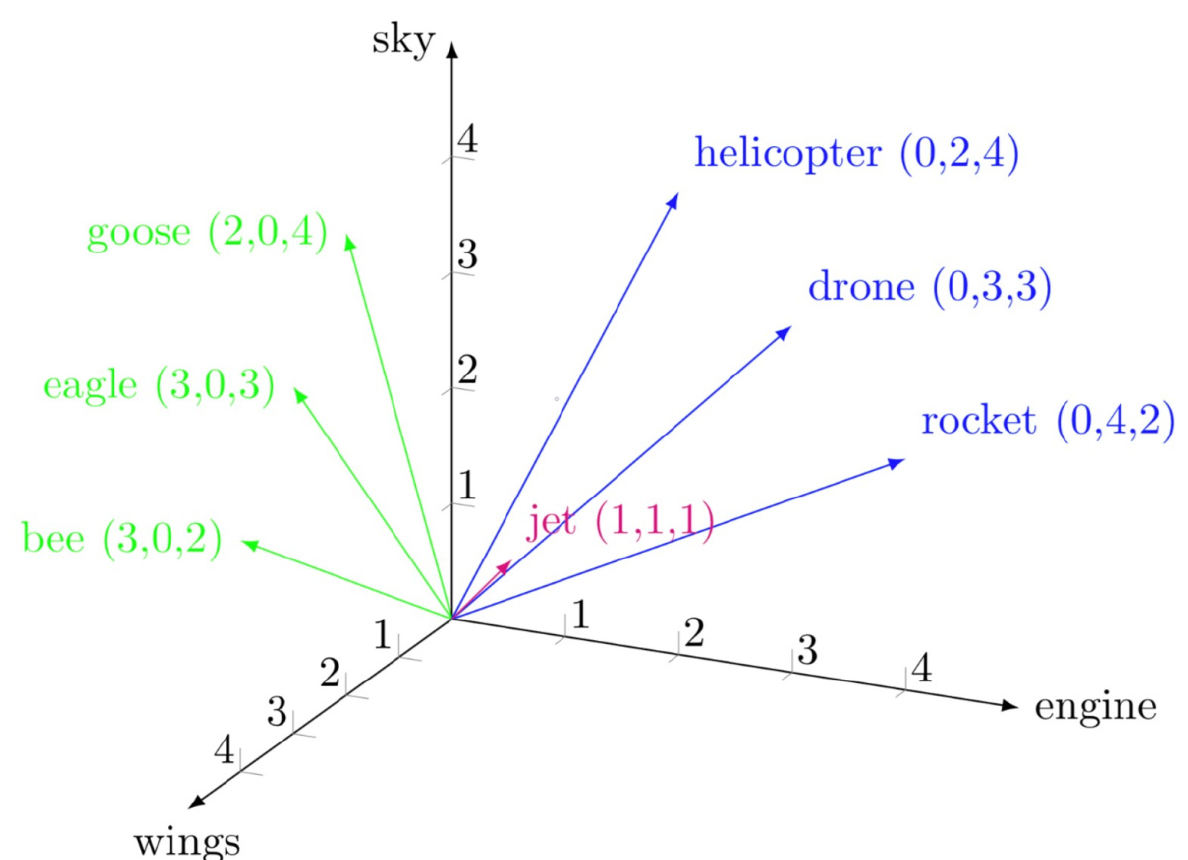
Figure 3. Vector space of seven words in three contexts. Guillaume Desagulier. Word embeddings: the (very) basics. Available on: https://corpling.hypotheses.org/495 (accessed on 28 July 2022).